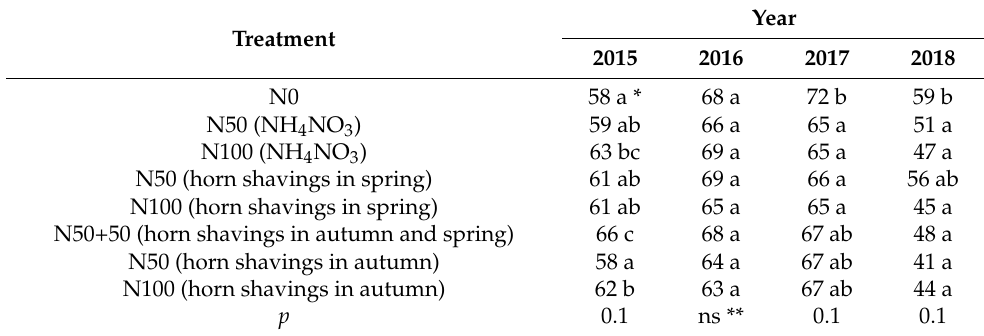
Table 10. Fertiliser effect on Ligol apple colour